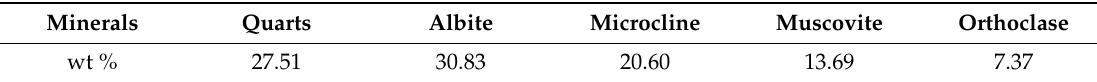
Table 2. Mechanical parameter of intact granite.